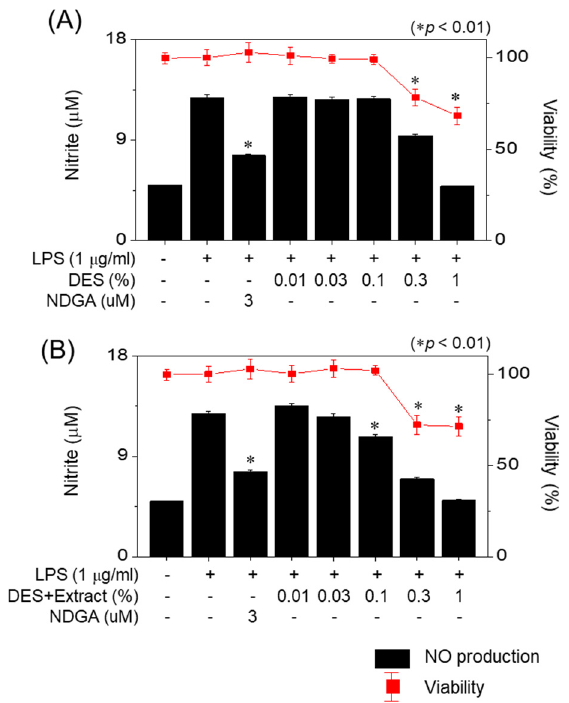
Figure 5. Effect of DES and PUL extract on the production of NO in LPS-stimulated RAW 264.7 cells. ( A ) DES synthesized using CC and GA; ( B ) PUL extract obtained using DES synthesized from CC and GA.